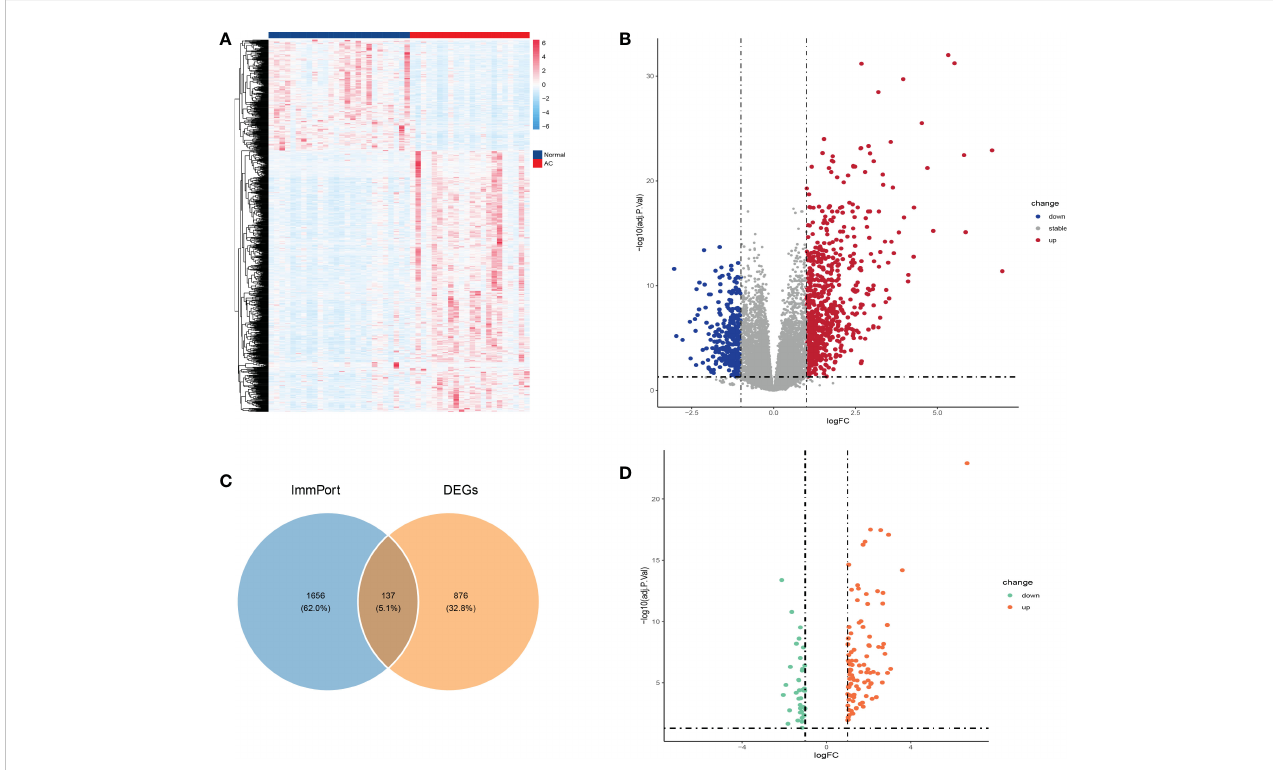
FIGURE 2 Identi fi cation of DEGs and DEIRGs. DEGs were visualized by heatmap (A) and volcano map (B) . Venn diagram was used to visualize the acquisition of 137 DEIRGs (C) . DEIRGs contain 99 up-regulated genes and 38 down-regulated genes (D) .